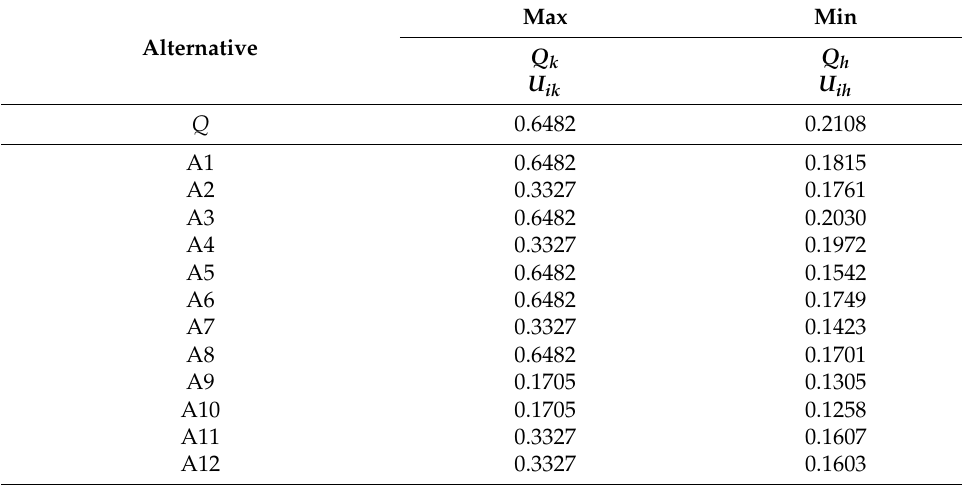
Table 16. Magnitude of optimal alternative and alternatives.